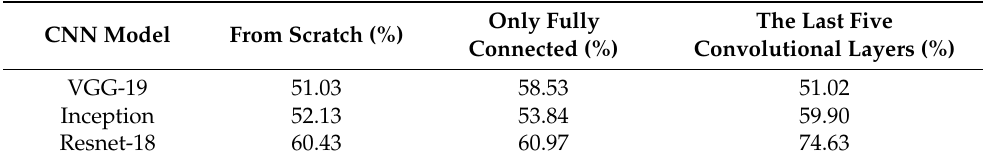
Table 2. Results of CNN models with freezing layers on the test dataset.